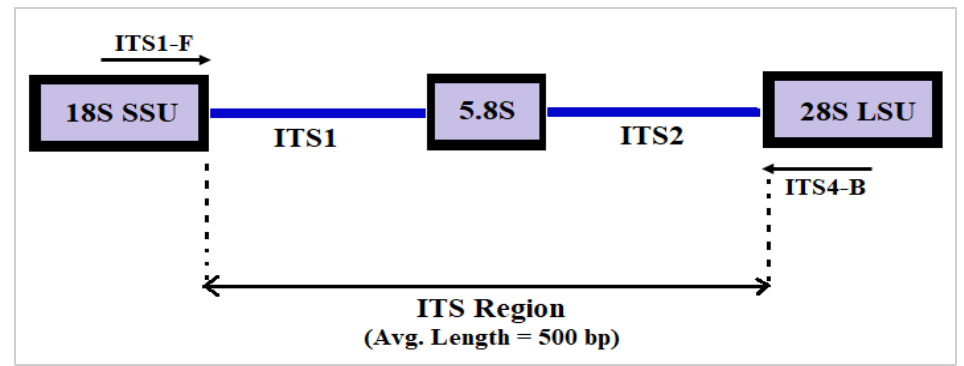
Figure 1. Schematic diagram of fungi ITS region consisting of ITS1 and ITS2 regions separated by 5.8S segment. ITS1-F and ITS4-B are widely used forward and reverse primers [41] to amplify the whole ITS region.